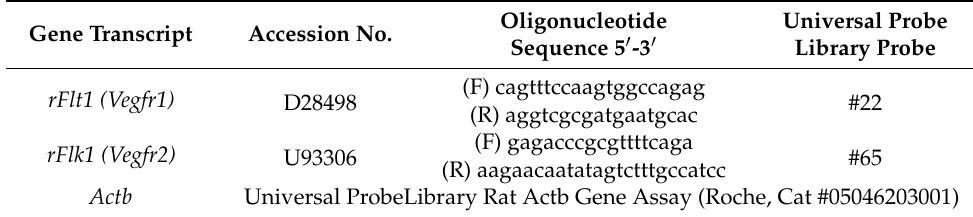
Table 2. The sequence of primers and TaqMan